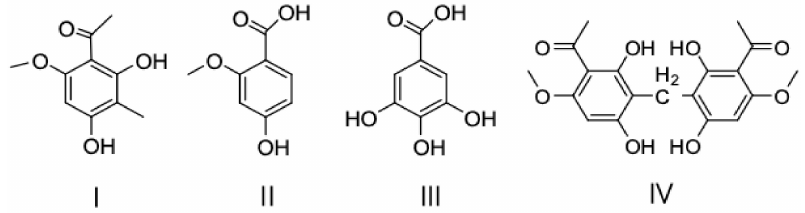
Figure 11. Structures of ECB (I) and three other similar compounds (II, III, and